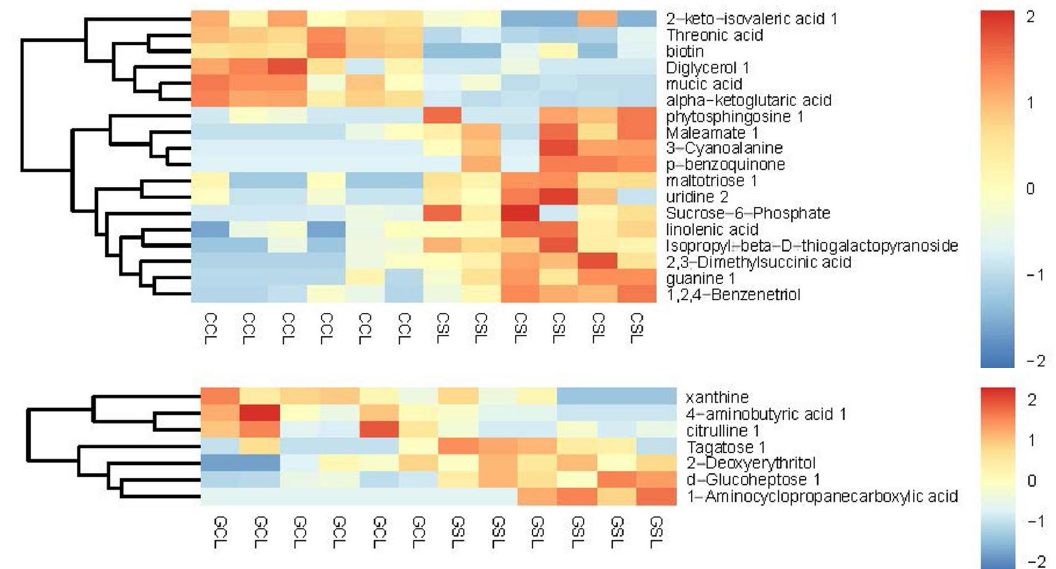
Figure 6. Heat map of the hierarchical clustering analysis of CDR-1 (CCL, CSL) and Gisela 5 (GCL, GSL). CCL, CSL, GSL, and GCL are the same as in Figure 4. Increasing and decreasing contents of metabolites are shown in orange and blue,